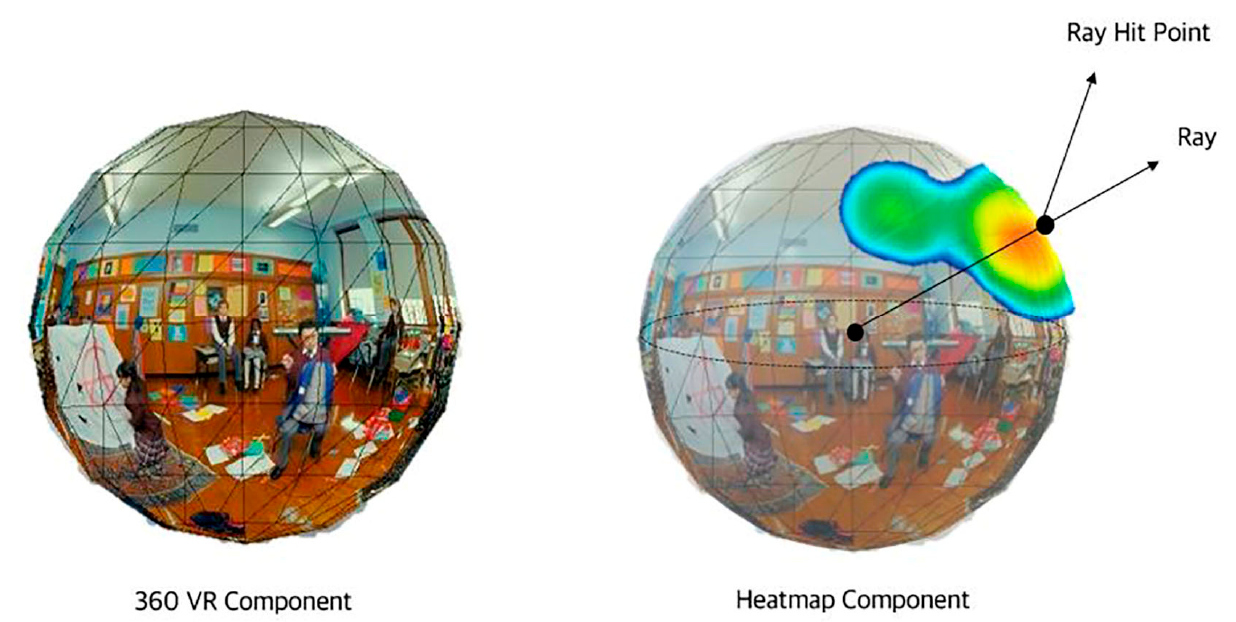
Figure 9. The 360-degree VR eye-tracking system component.